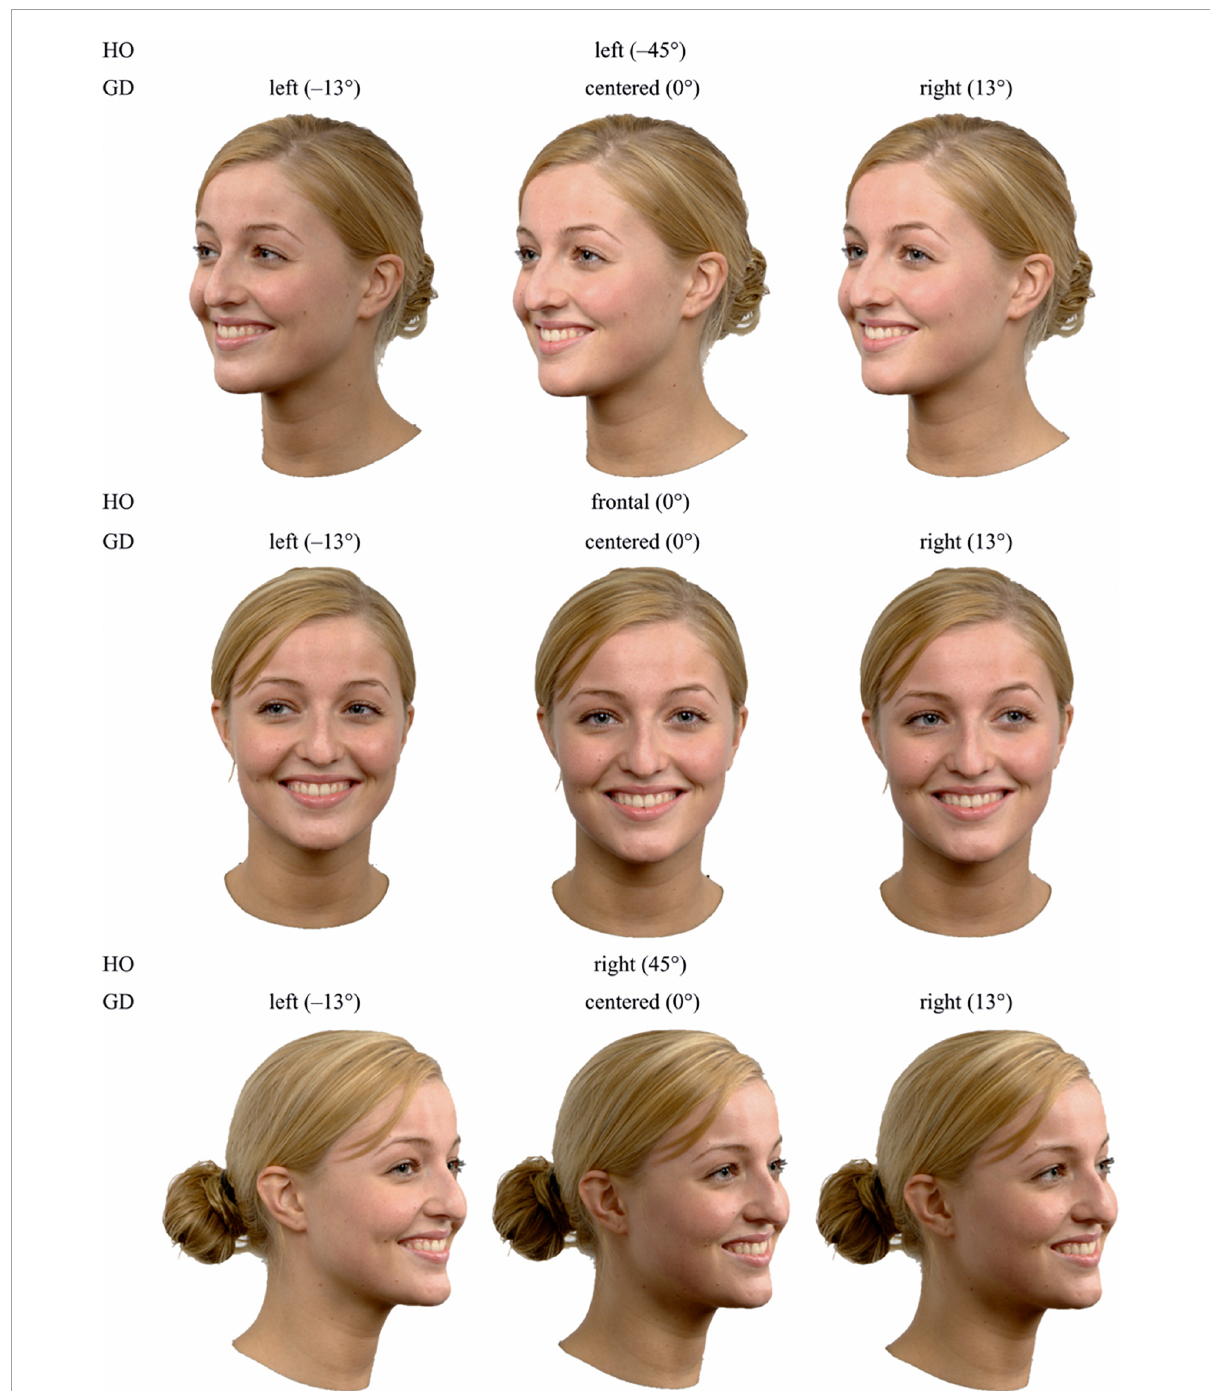
FIGURE2 Example stimuli for uncovered faces, showing all nine possible combinations of gaze direction and head orientation for model 1 and the facial expression happiness. HO, head orientation; GD, gaze direction.